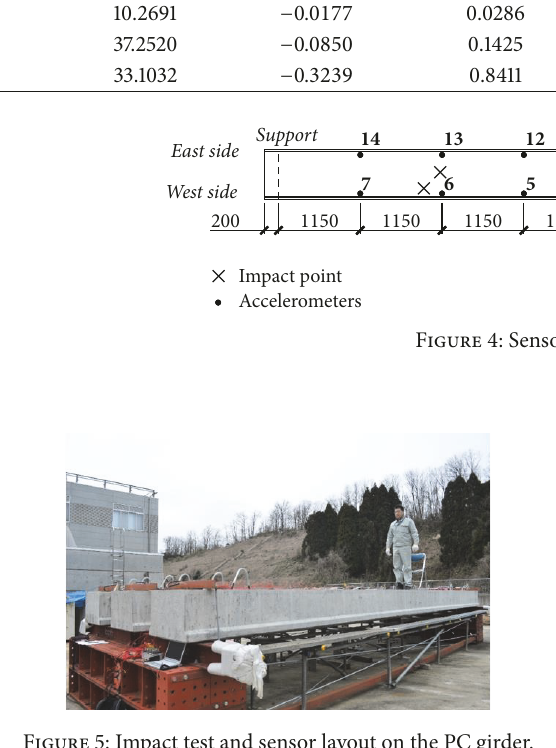
Figure 5: Impact test and sensor layout on the PC